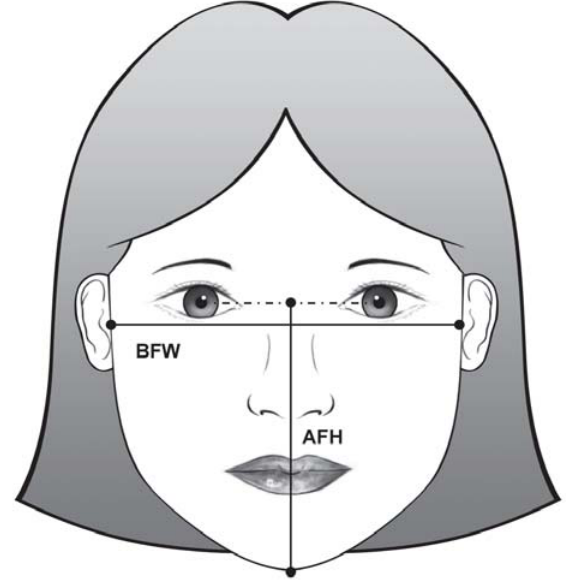
Figure 1- Facial dimensions: AFH, anterior face height (the linear distance between the interpupillary plane and the inferior margin of the menton); BFW, bizygomatic facial width (the linear distance between the bilateral most exterior points of the zygomatic arches)